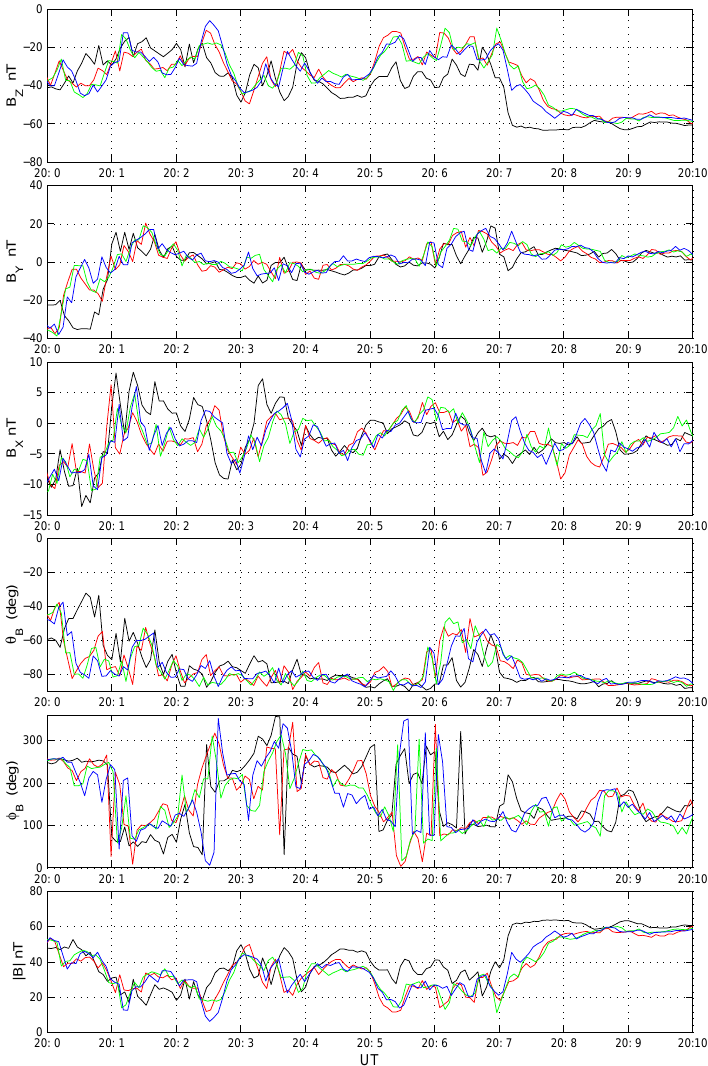
Fig. 11. The three magnetic field components, the angles θ and φ , and the field magnitude between 20:00 and 20:10UT on 13 February